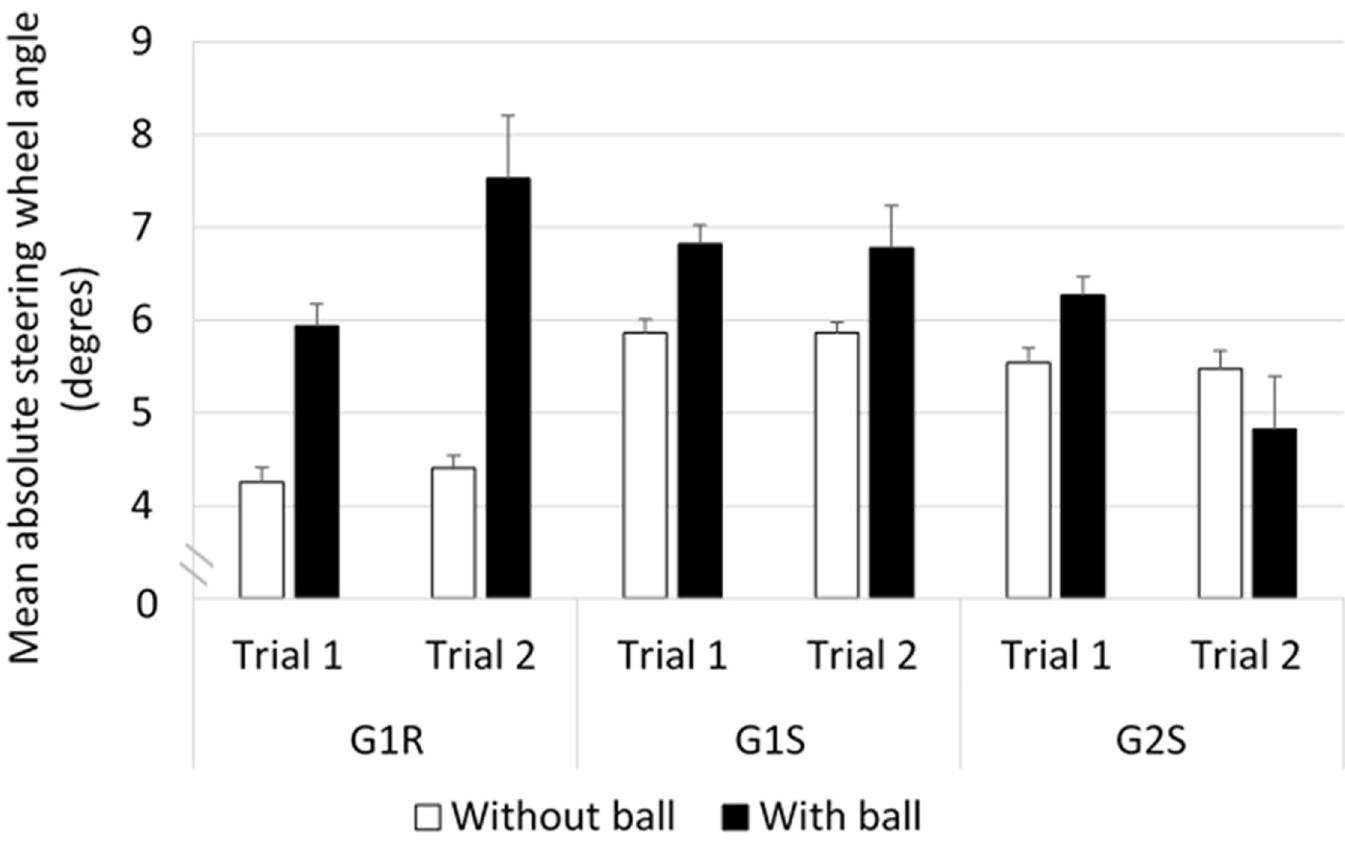
Fig 10. Mean absolute steering wheel